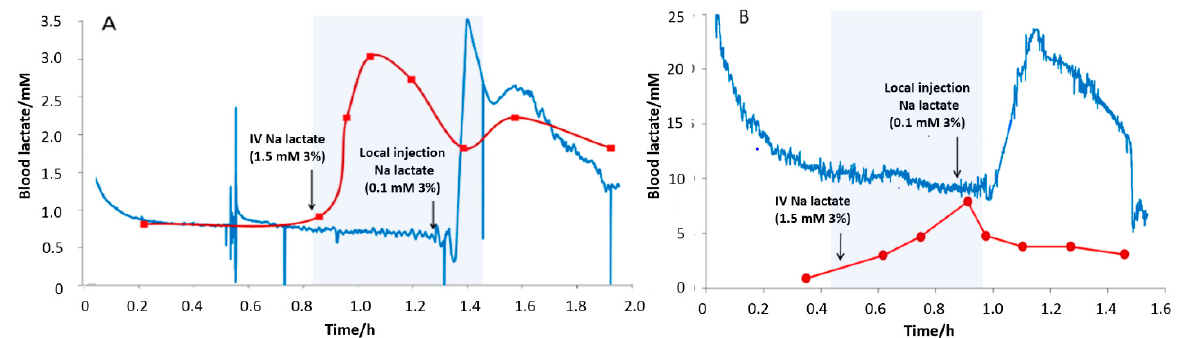
Figure 8. Lactate monitoring in Sprague Dawley rats using subcutaneous dorsally implanted needle electrodes. Intravenous Na lactate given via the tail vein. ( A , B ) represent studies of two different animals. Red curves are blood lactate levels, blue curves are continuously monitored tissue lactate by biosensor. The blue shading in each represents the period of IV lactate infusion.